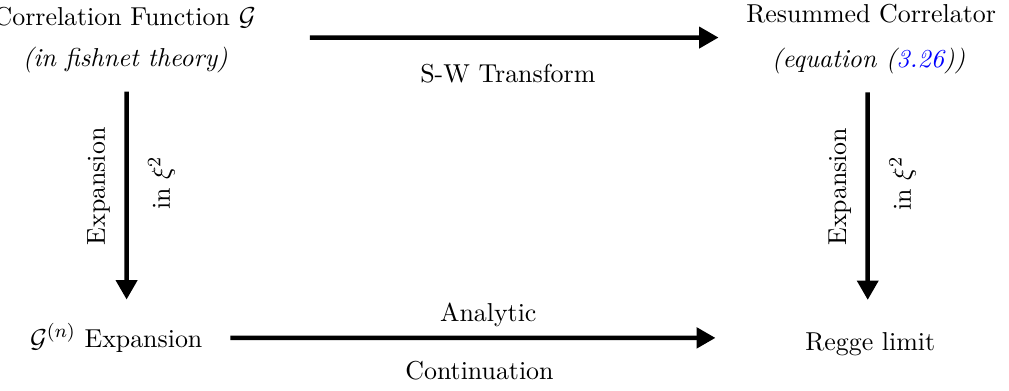
Figure 3 . A sketch of the processes evaluated in the following sections. We analyze the Sommerfeld- Watson resummation in generic conformal theories and demonstrate that the diagram commutes in the fishnet